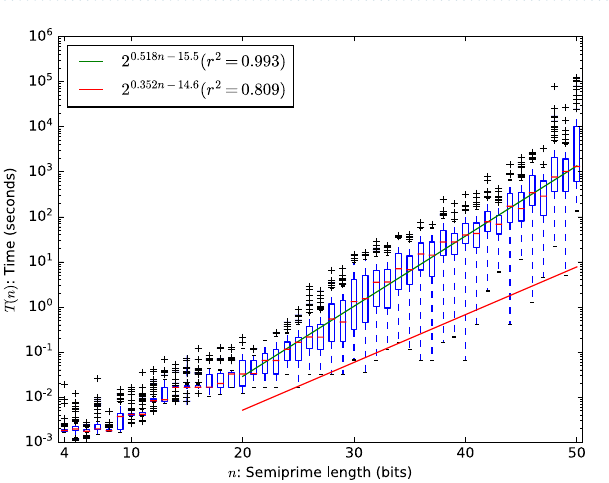
Figure 3. Histogram of the MapleCOMSPS runtime on factoring semi-primes using schoolbook multiplication.